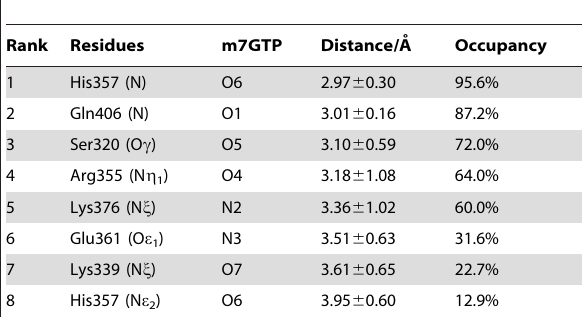
bonding interactions between the PB2 cap binding domain and cap analog m7GTP.